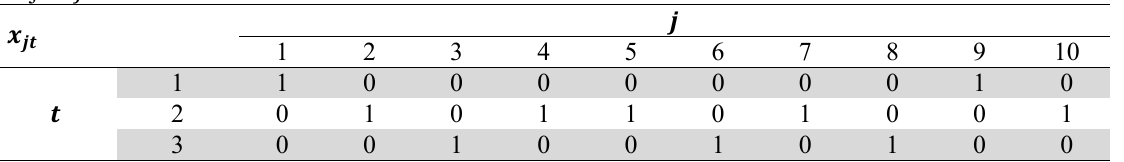
The number of active projects of the set (cid:1862) in period (cid:1863) is between (cid:1865) (cid:2175) (cid:2193)(cid:2196) (cid:4666)(cid:2206)(cid:4667)